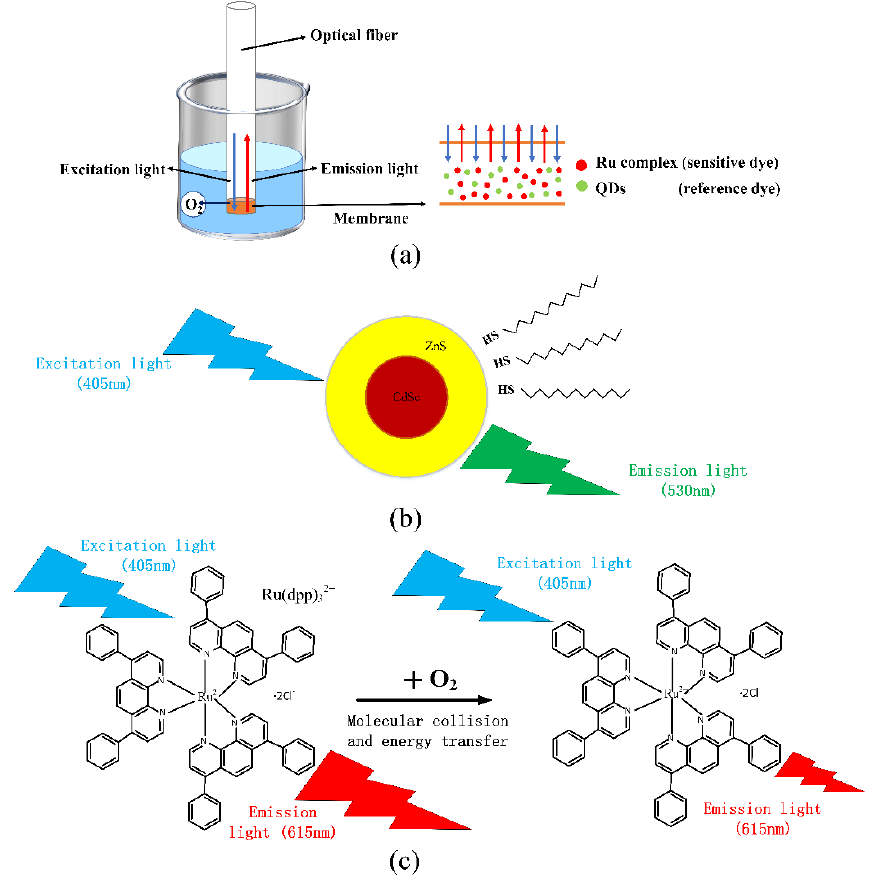
Figure 1. Schematic diagram of the principle of the ratiometric DO sensor ( a ) fluorescence quenching of optical dissolved oxygen sensor ( b ) excitation of QDs ( c ) principle of fluorescence quenching effect.